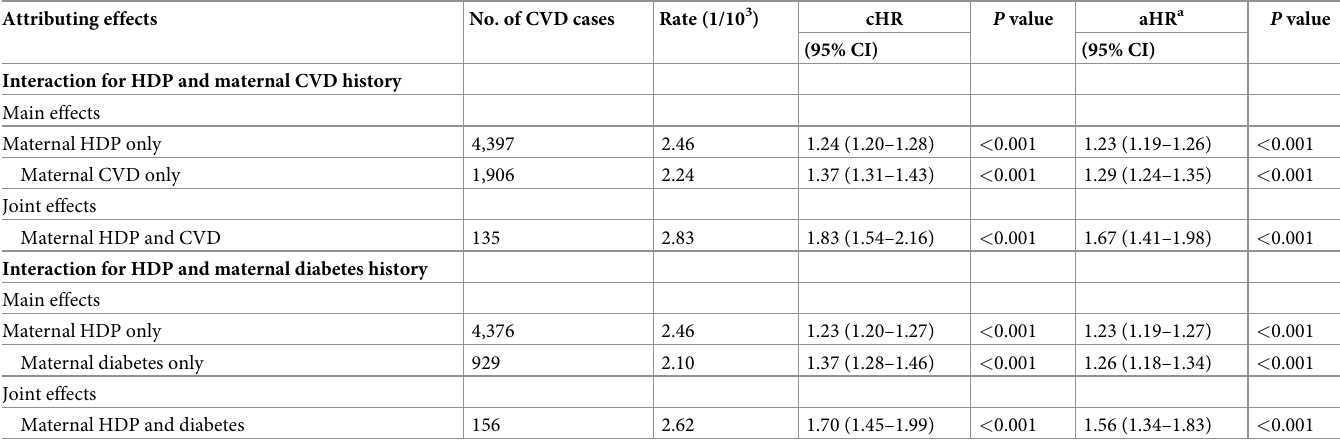
Table 3. The joint effect of maternal HDP and maternal CVD/maternal diabetes history before childbirth on early-onset CVD in offspring. Attributing